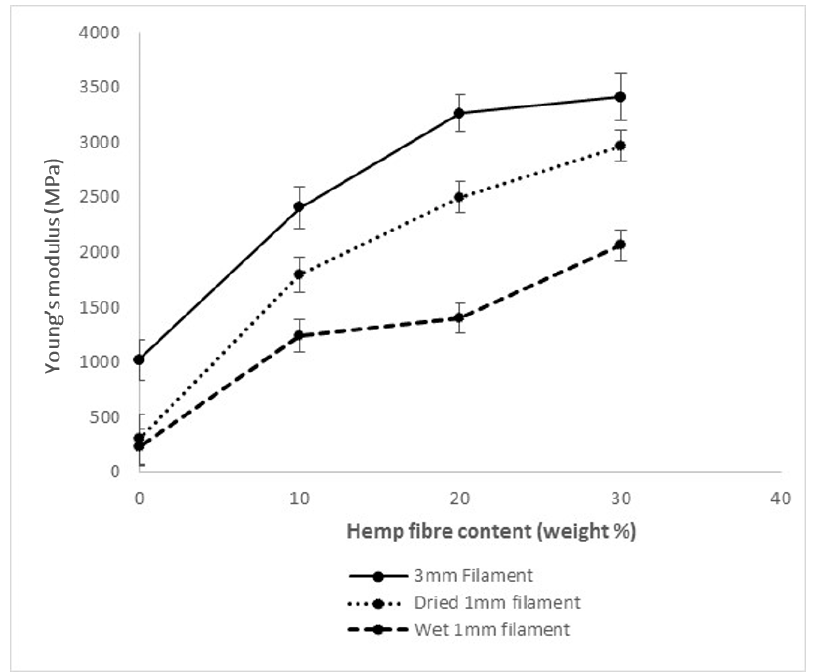
Figure 12. Young’s modulus comparison between harakeke reinforced 3 mm, 1 mm wet and 1 mm dry filaments.